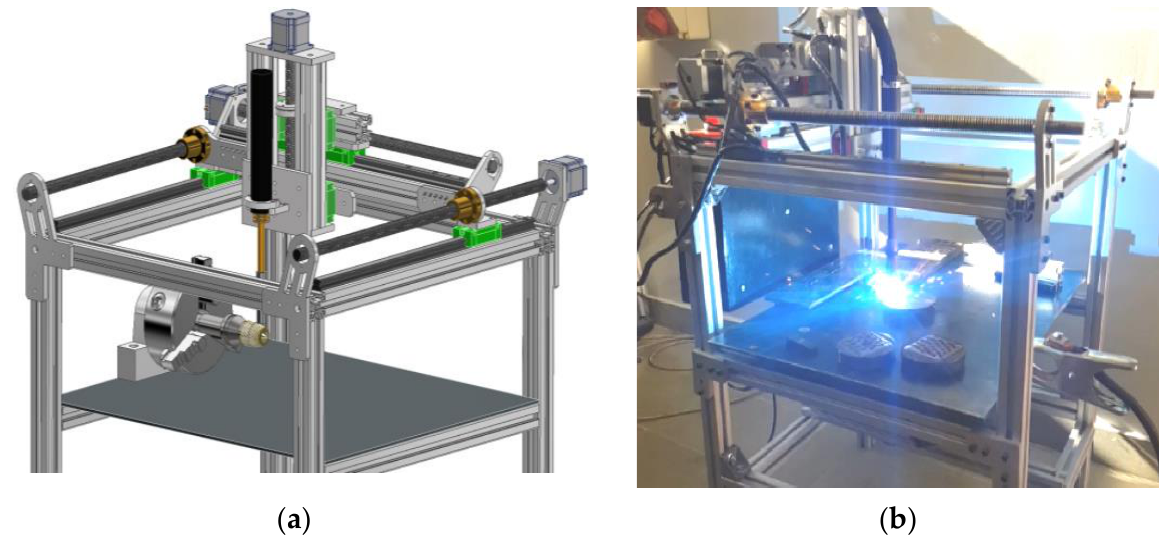
Figure 4. View of the CNC Hardfacing Machine, codenamed NaPawlik v2.0. ( a ) depicts the CAD model, ( b ) shows the device in action.